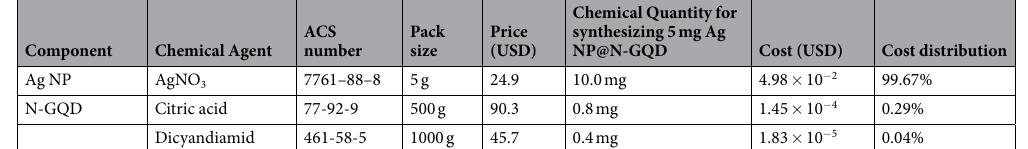
Table 3. Analysis of itemized cost for synthesizing 5 mg Ag NP@N-GQD, which requires 0.8 mg N-GQD and 10 mg AgNO 3 . The measured baseline glucose level (diluted by 10 times) is 0.21 mM. The first and second values in the column of “Estimated increase in glucose concentration” give the mean value and the standard deviation, respectively. Note that the Mean Percent Error is calculated as ( Δ Estimated − Δ Expected )/ Δ Expected × 100%, where Δ Estimated represents the mean estimated increase in glucose concentration and increase in glucose